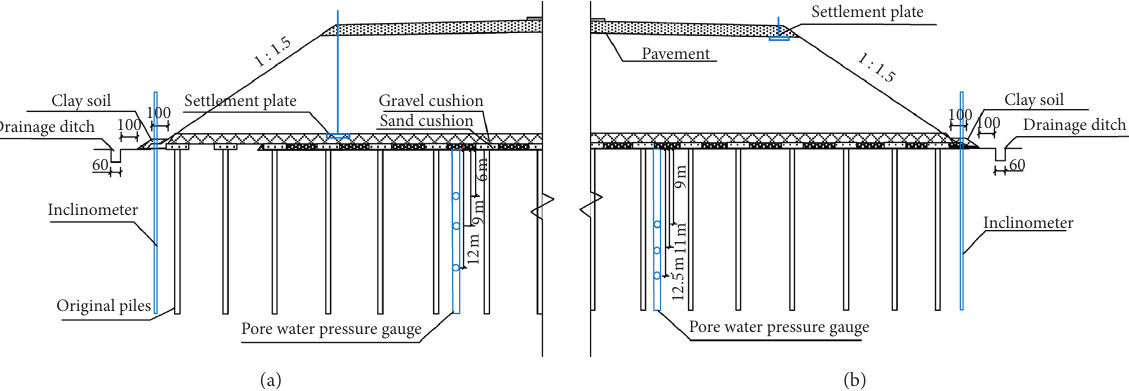
Figure 13: Schematic of the monitoring section. (a) Sliding section. (b) Cracking section.